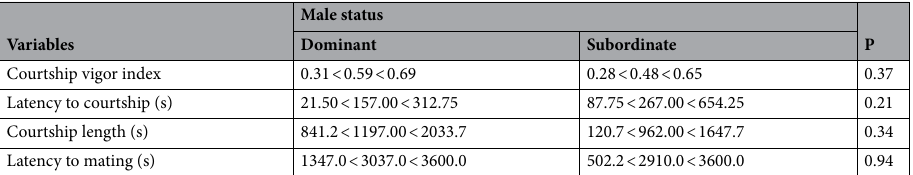
Table 6. Duration of courtship variables of Anastrepha curvicauda dominant and subordinate (7–8 days old) males. Non-choice experiments. Reported values are Q1 < Median < Q3 (n = 15). Mann–Whitney test, p > 0.05.